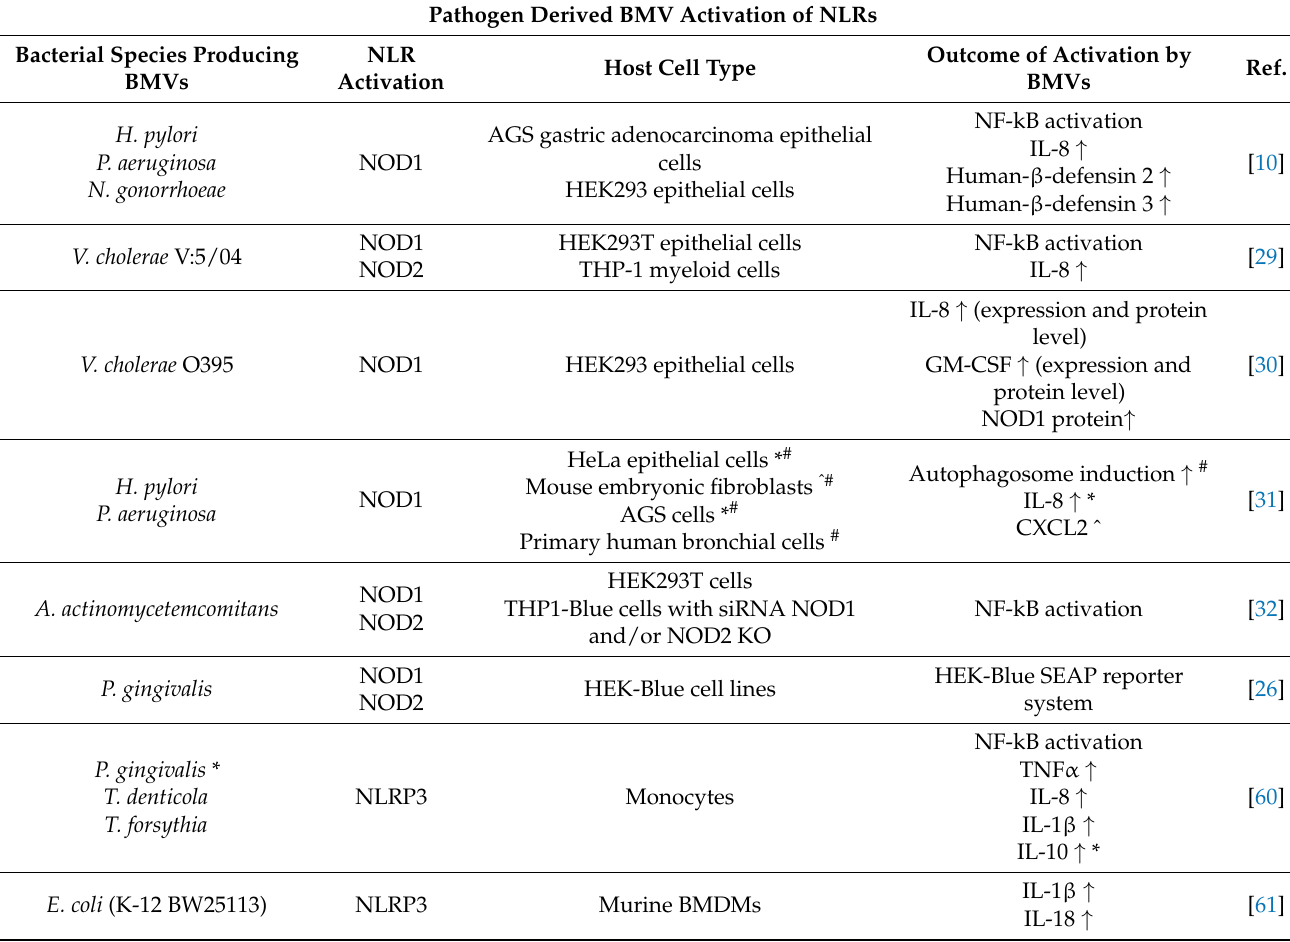
Table 1. Chronological summary of studies demonstrating the detection of pathogen and commensal derived BMVs by NLRs and the downstream consequences.